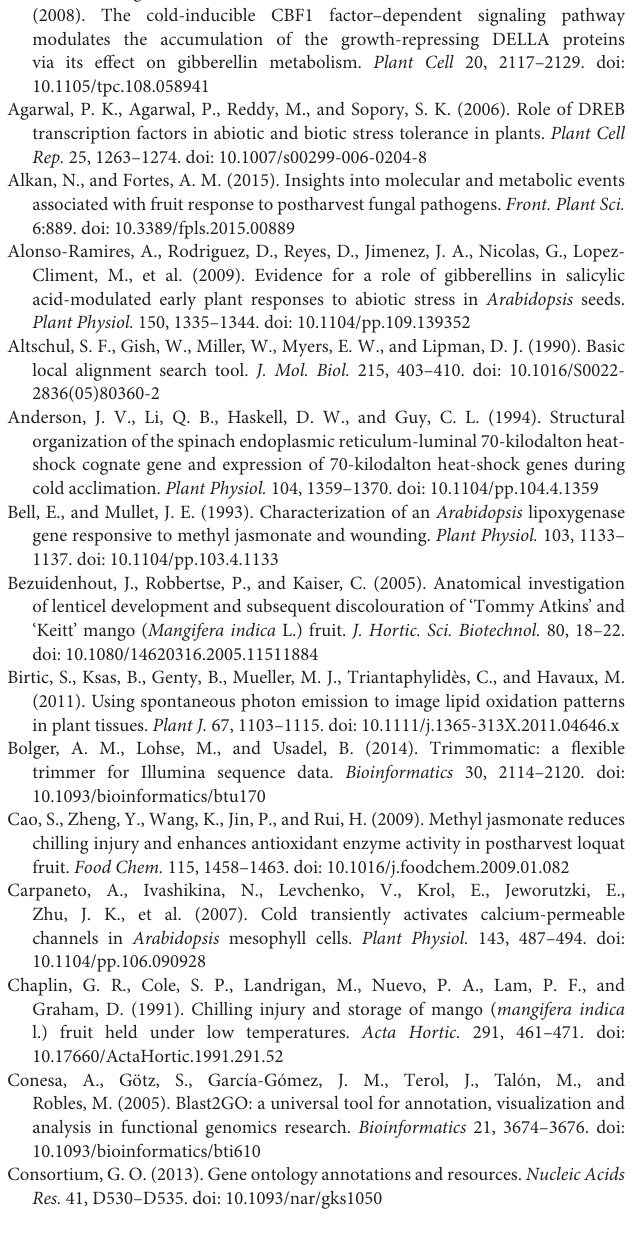
enzyme code (EC), InterProScan, RPKM of different biological replicates, cluster. Also presented are fold change, p -value and FDR (adjusted p -value) of different comparisons. TABLE S2 | Abbreviations and transcript identification presented and divided according to pathways and the Figures in which they